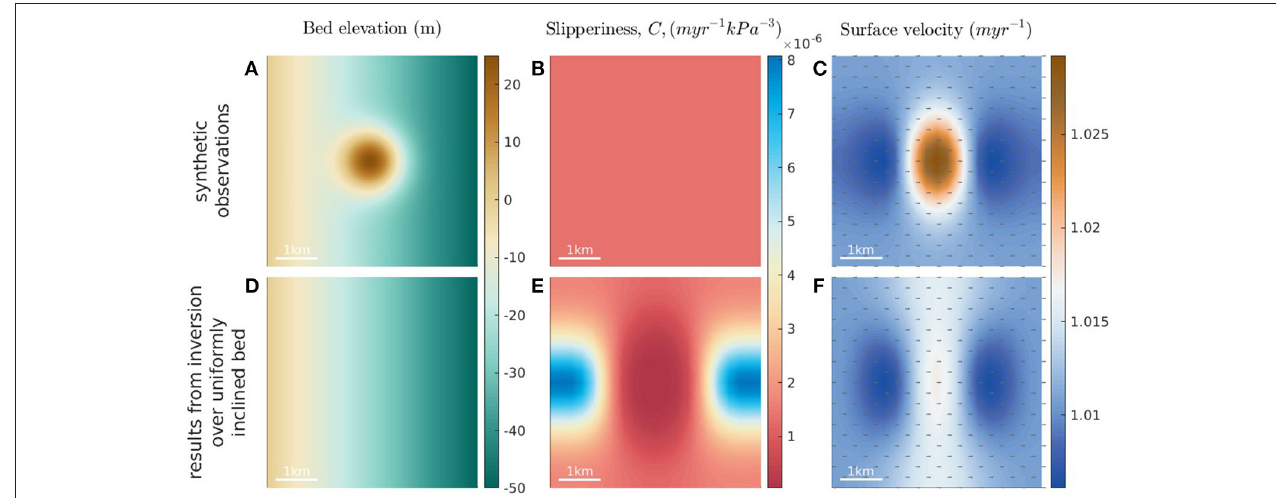
FIGURE 1 | Solutions from a 3D Stokes model set up over a 5 × 5 × 1km 3 inclined slab with periodic boundary conditions. The (A–C) of plots shows the bed perturbation, a constant slipperiness field and then the resultant surface velocity from solving 3D Stokes over this setup. The (D–F) of plots then shows the retrieved slipperiness field and resultant surface velocity when using an inverse method to try and match the surface observations but over a flat bed.